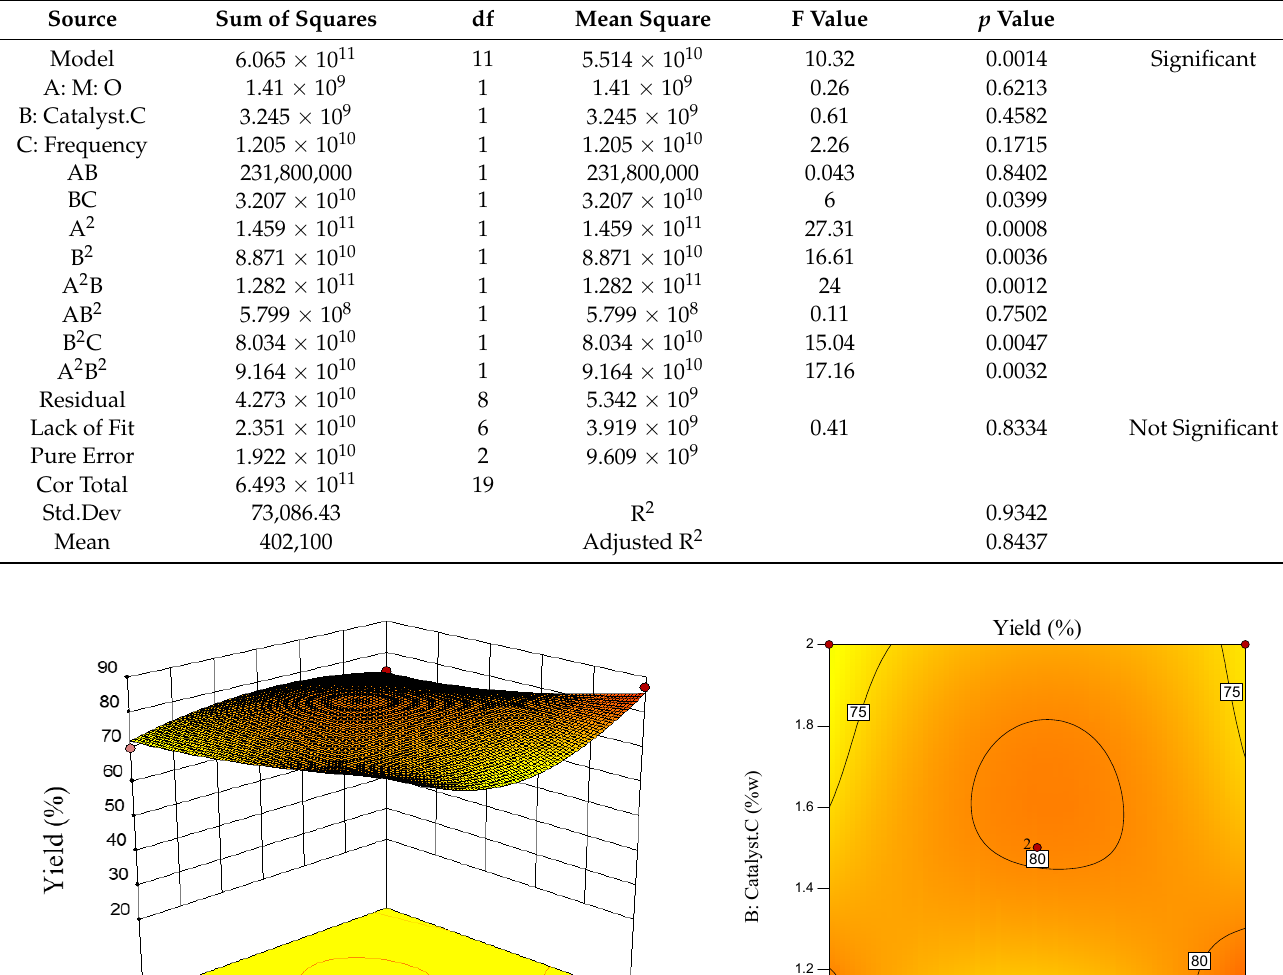
Table 4. Analysis of variance (ANOVA) for the proposed response surface model.